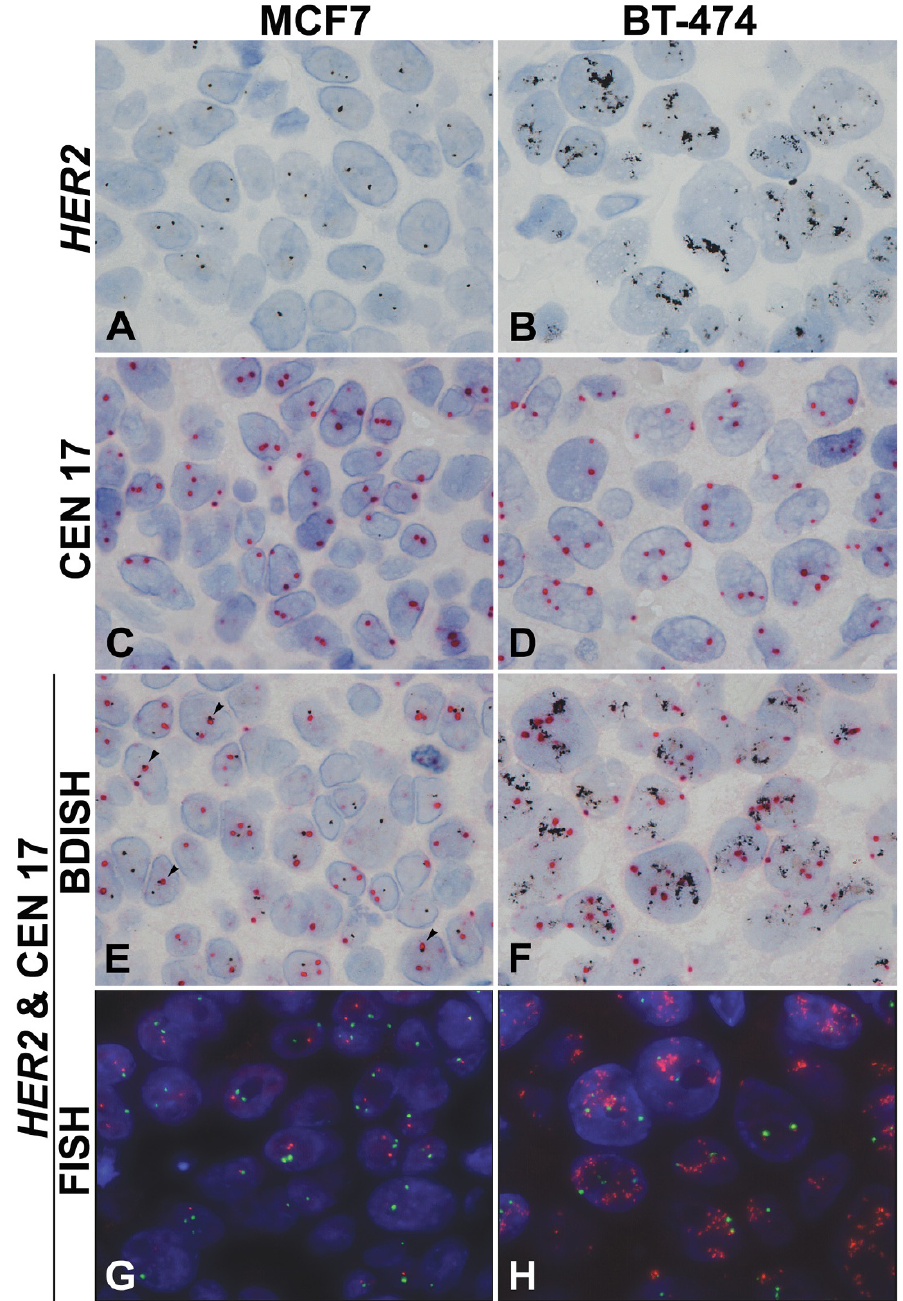
Figure 2 Brightfield in situ hybridization and dual color fluorescence in situ hybridization (FISH) for HER2 and CEN 17 . HER2 and CEN 17 detection with formalin-fixed, paraffin-embedded xenograft tumors, MCF7 (non-amplified HER2 gene and chromosome 17 polysomy) (A, C, E, G) and BT-474 (amplified HER2 gene and chromosome 17 polysomy) (B, D, F, H). Normal HER2 gene signal is seen as black dots in the nuclei of MCF7 xenograft tumor (A) while amplified HER2 gene signal is seen as clusters of black dots in the nuclei of BT-474 tumor (B). CEN 17 signal is detected as red dots that are slightly larger than silver black dots (C, D). Double staining of HER2 gene and CEN 17 is obtained with silver grains and red dots (E, F). Individual HER2 gene and CEN 17 signals can be still recognized when both targets are co-localized (arrow heads, E). HER2 FISH signal is red- orange and CEN 17 FISH signal is green in the blue nuclei counterstained with DAPI (G, H).